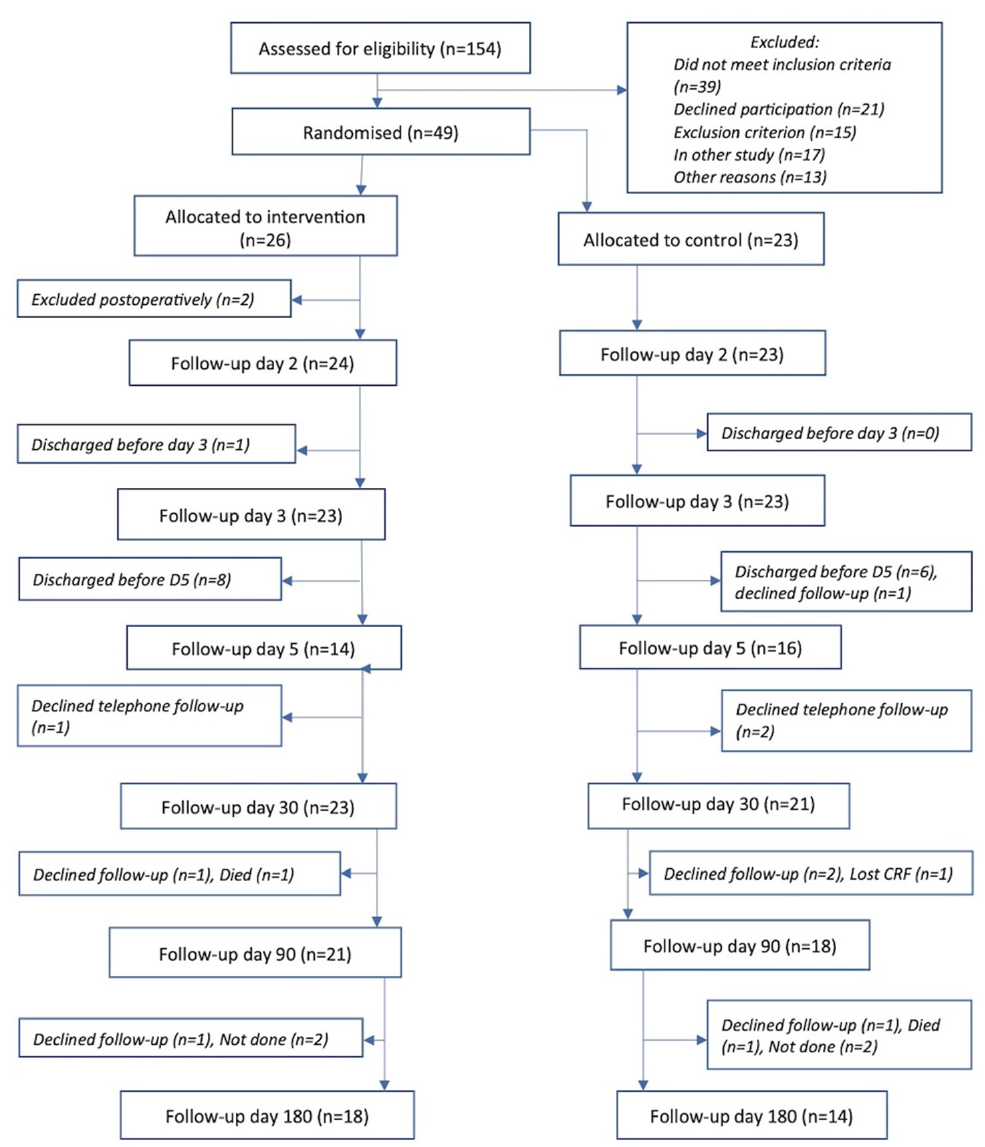
Figure 1. Consort Figure 1. Consort diagram.